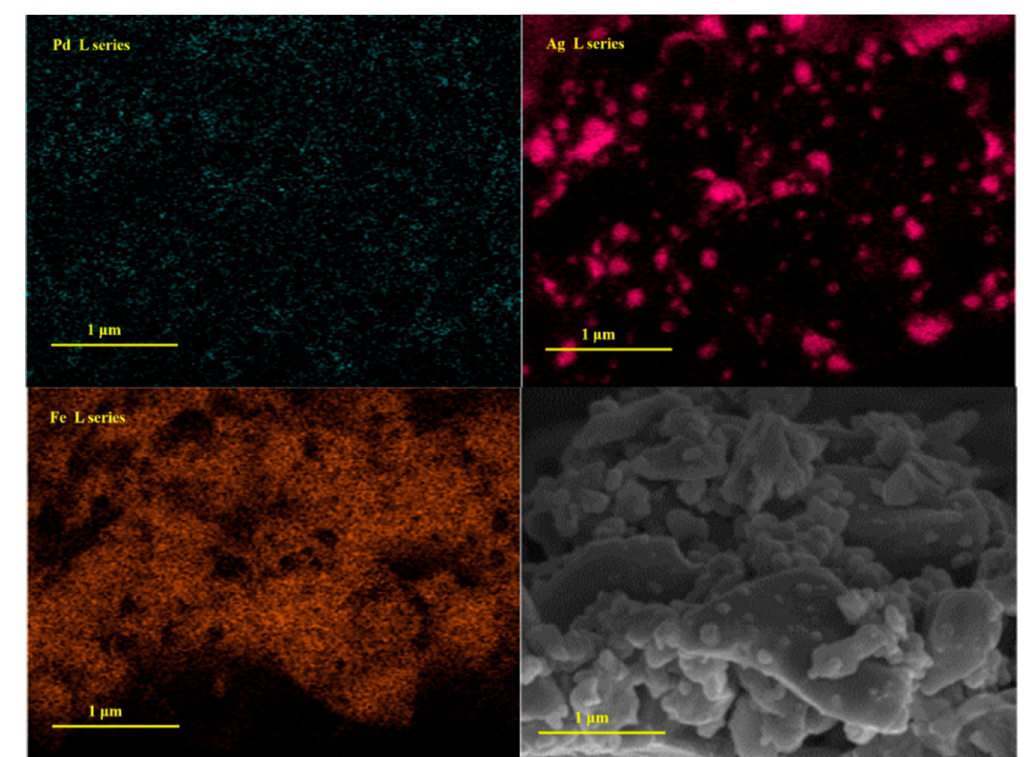
Figure 3. SEM image of Pd infiltrated Ag-LSCF anode surface before testing.